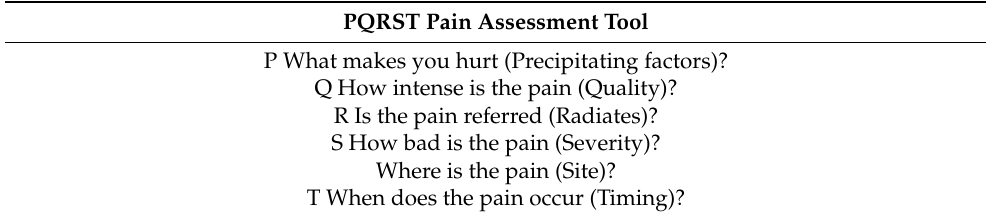
Table 1. PQRST pain assessment